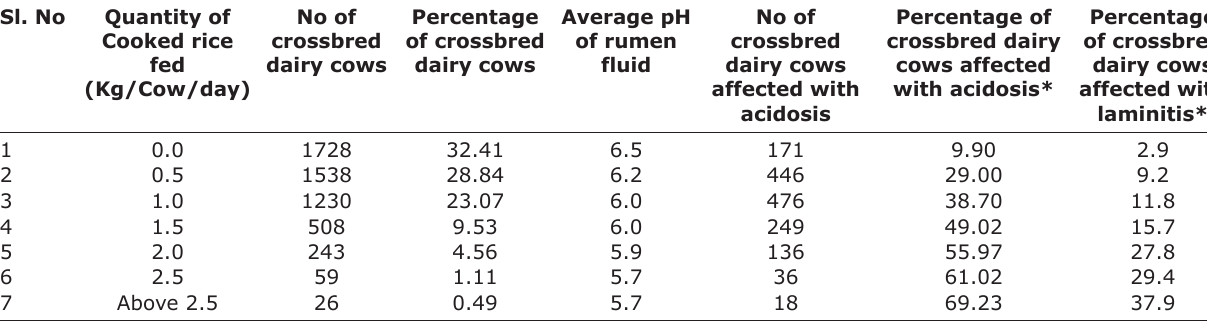
Table-2: Quantity of rice (cooked) fed and incidence of acidosis in the study animals Sl. No Quantity of Cooked